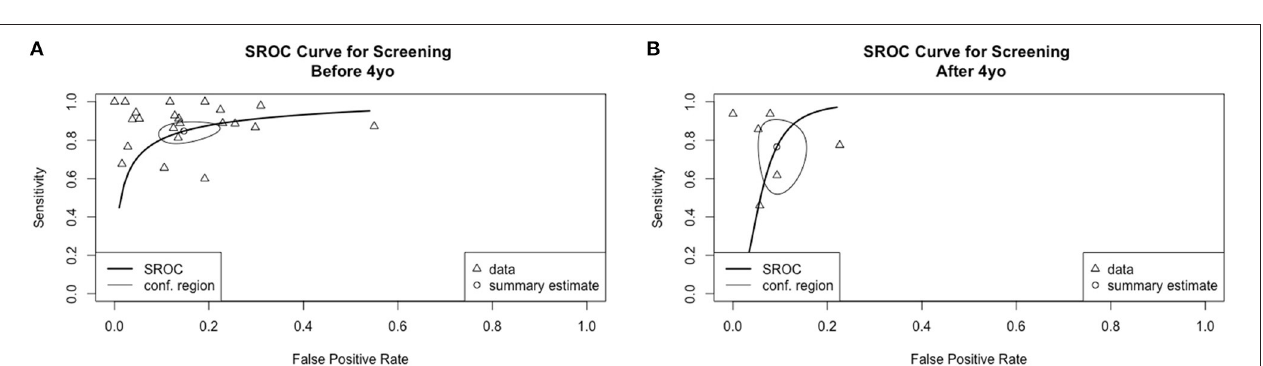
FIGURE 4 | Summary receiver operating characteristics curves for screening tools administered by (A) parents/caregivers and (B) trained examiners.